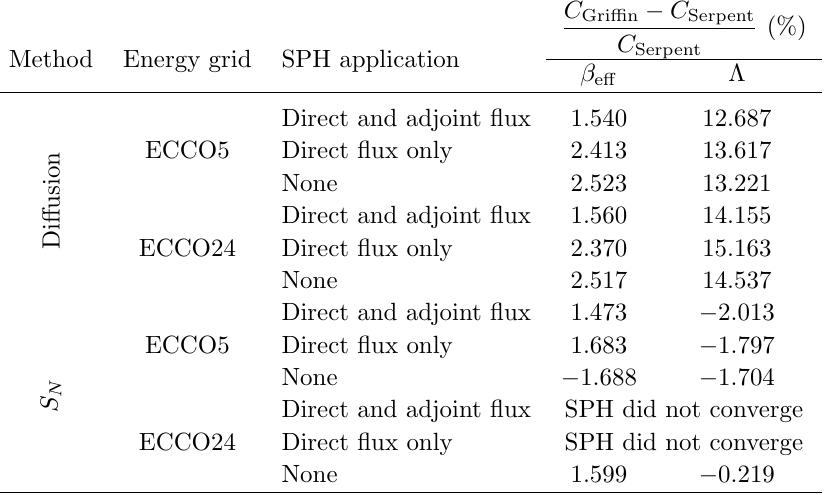
Table 16. Relative differences between Griffin and Serpent Godiva kinetics parameters.